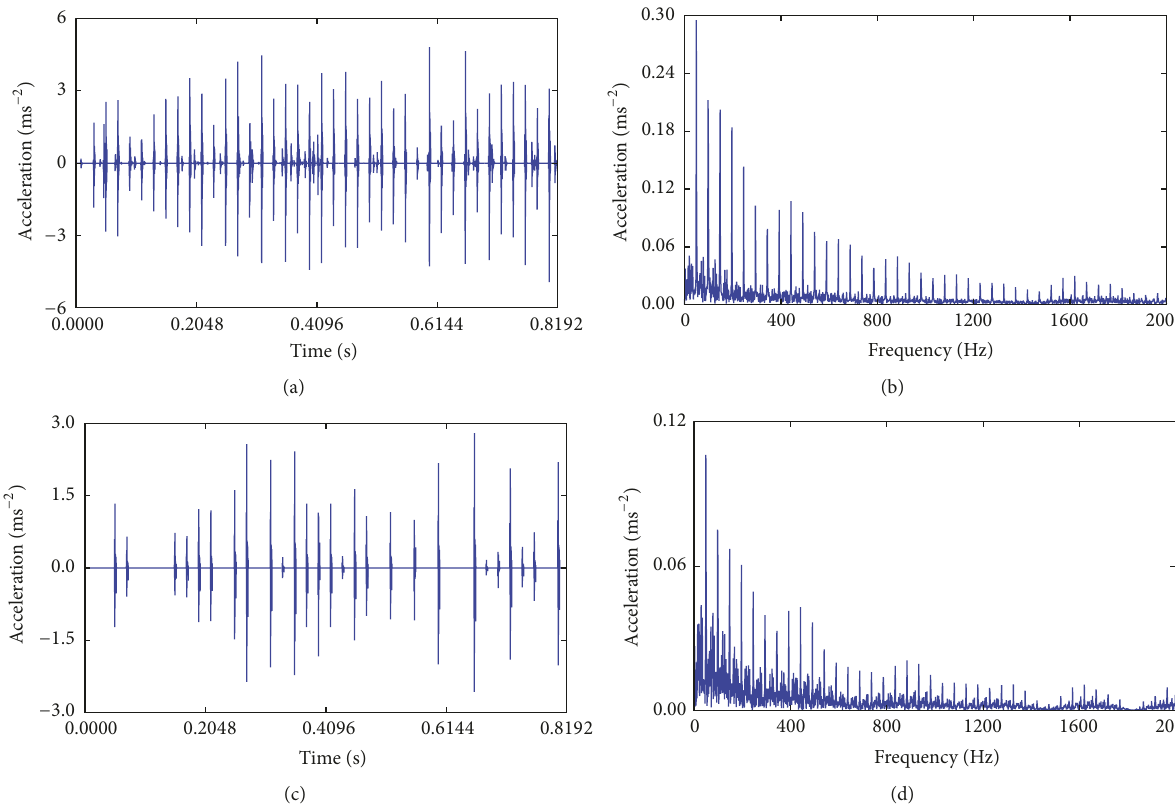
Figure 6: The extracted impulse: (a) by proposed appropriately sparse impulse extraction; (b) the envelope spectra of (a); (c) three other indicators; (d) the envelope spectra of (c).